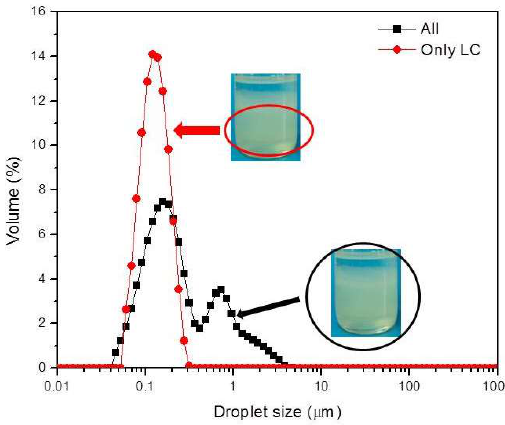
Figure 6. Droplet size distribution for a water content of 20.0% in the dilution line S/O 25/75 at 30 °C. All refers to the whole dispersed system (O + LC) and Only LC to the liquid crystal phase only.